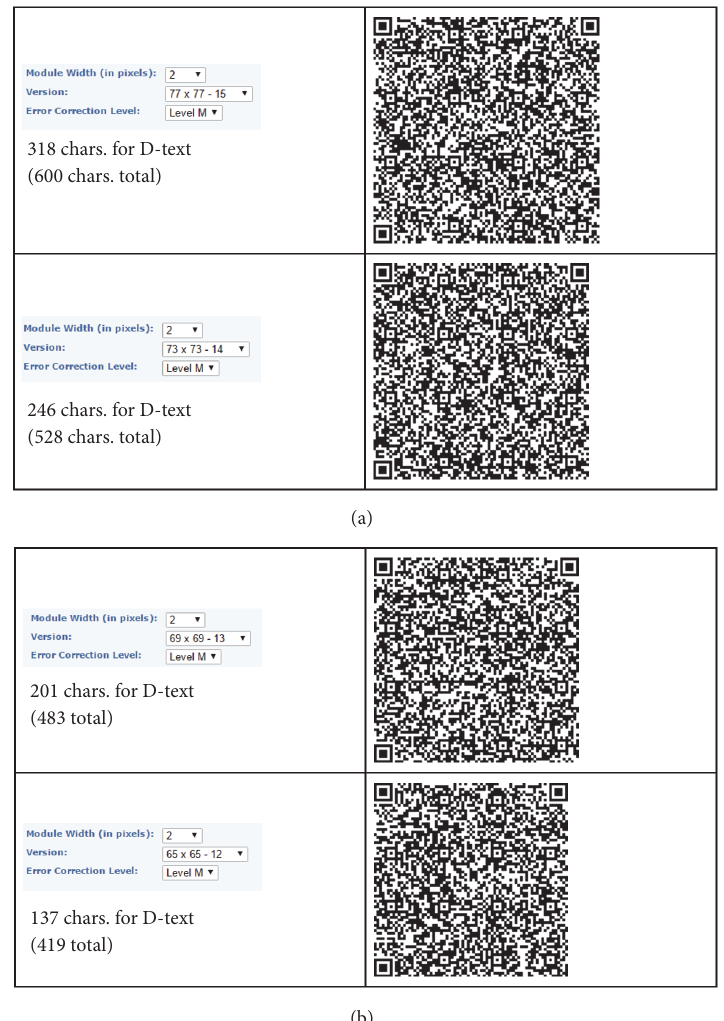
Figure 2: (a) Examples of QR codes encoding the required information (version 15 and version 14). (b) Examples of QR codes encoding the required information (version 13 and version